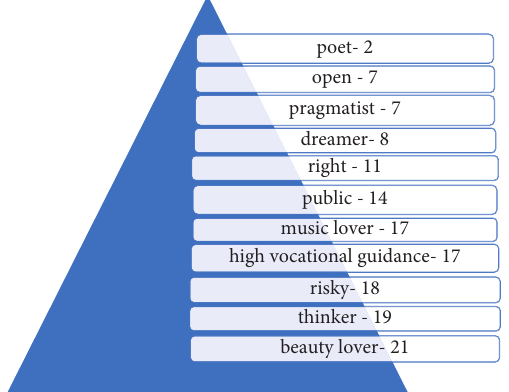
Figure 2: Initial level of student creativity.